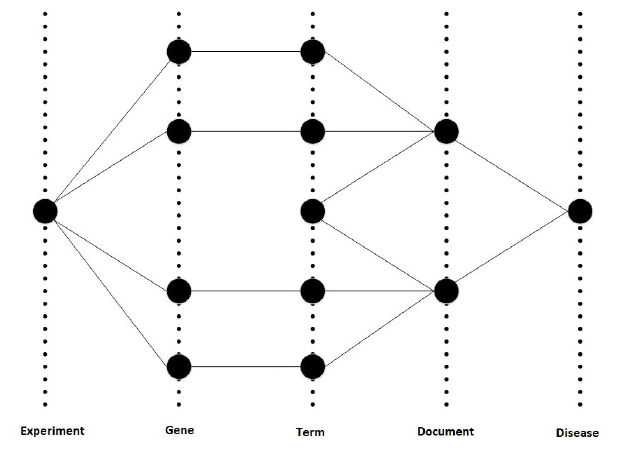
Figure 7. Example of bisociative network [8]